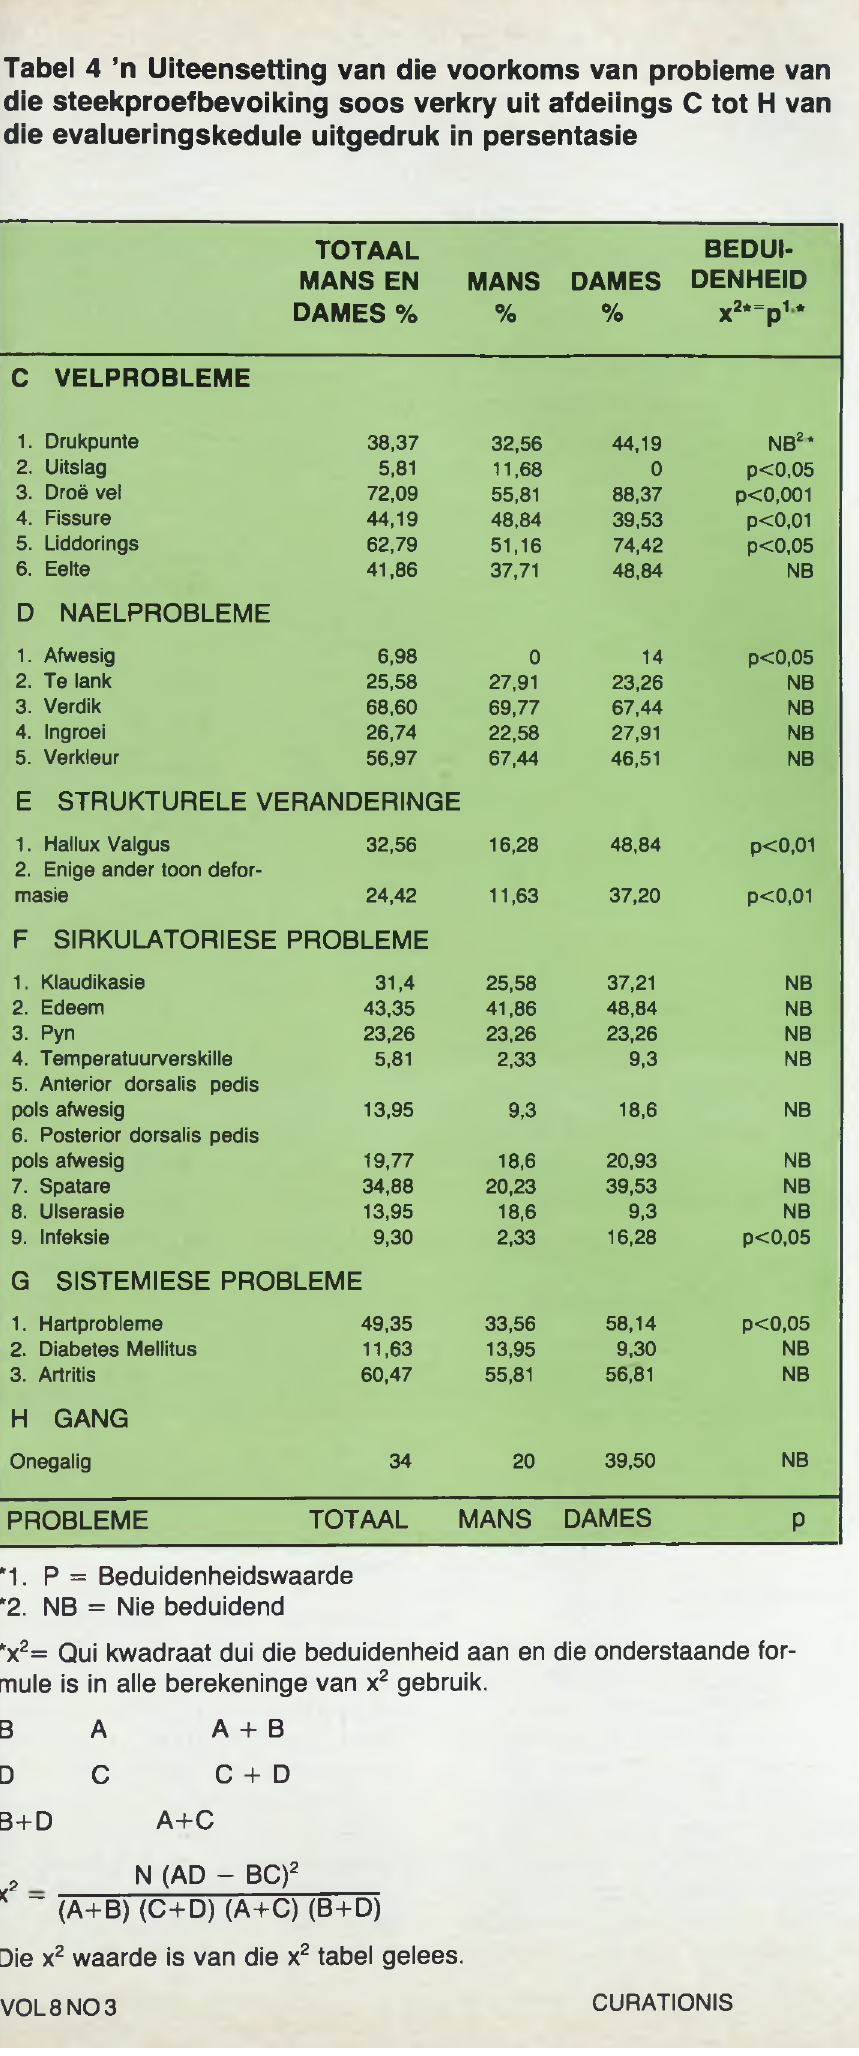
figuur 1) verkry is. ’n Kliniese ondersoek is terselfdertyd